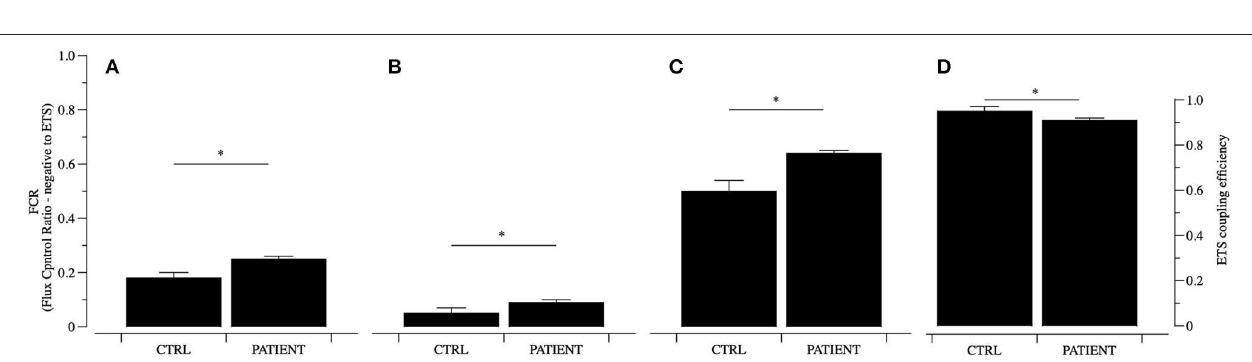
FIGURE 1 | Determination of the A3243G mutation in the mtDNA portion coding for tRNA leu(UUR). (A) DNA sequencing chromatogram for subject DNA product. The peak labeled with an arrow represented the presence of an adenine (A) in the 3243 region of the mtDNA gene. (B) Restriction enzyme analysis of PCR products. Lane 1,25 bp DNA ladder (Invitrogen); lane 2, normal control DNA product not digested; lane 3, normal control DNA product digested with ApaI ; lane 4, patient DNA product not digested; lane 5, patient DNA product digested with ApaI .